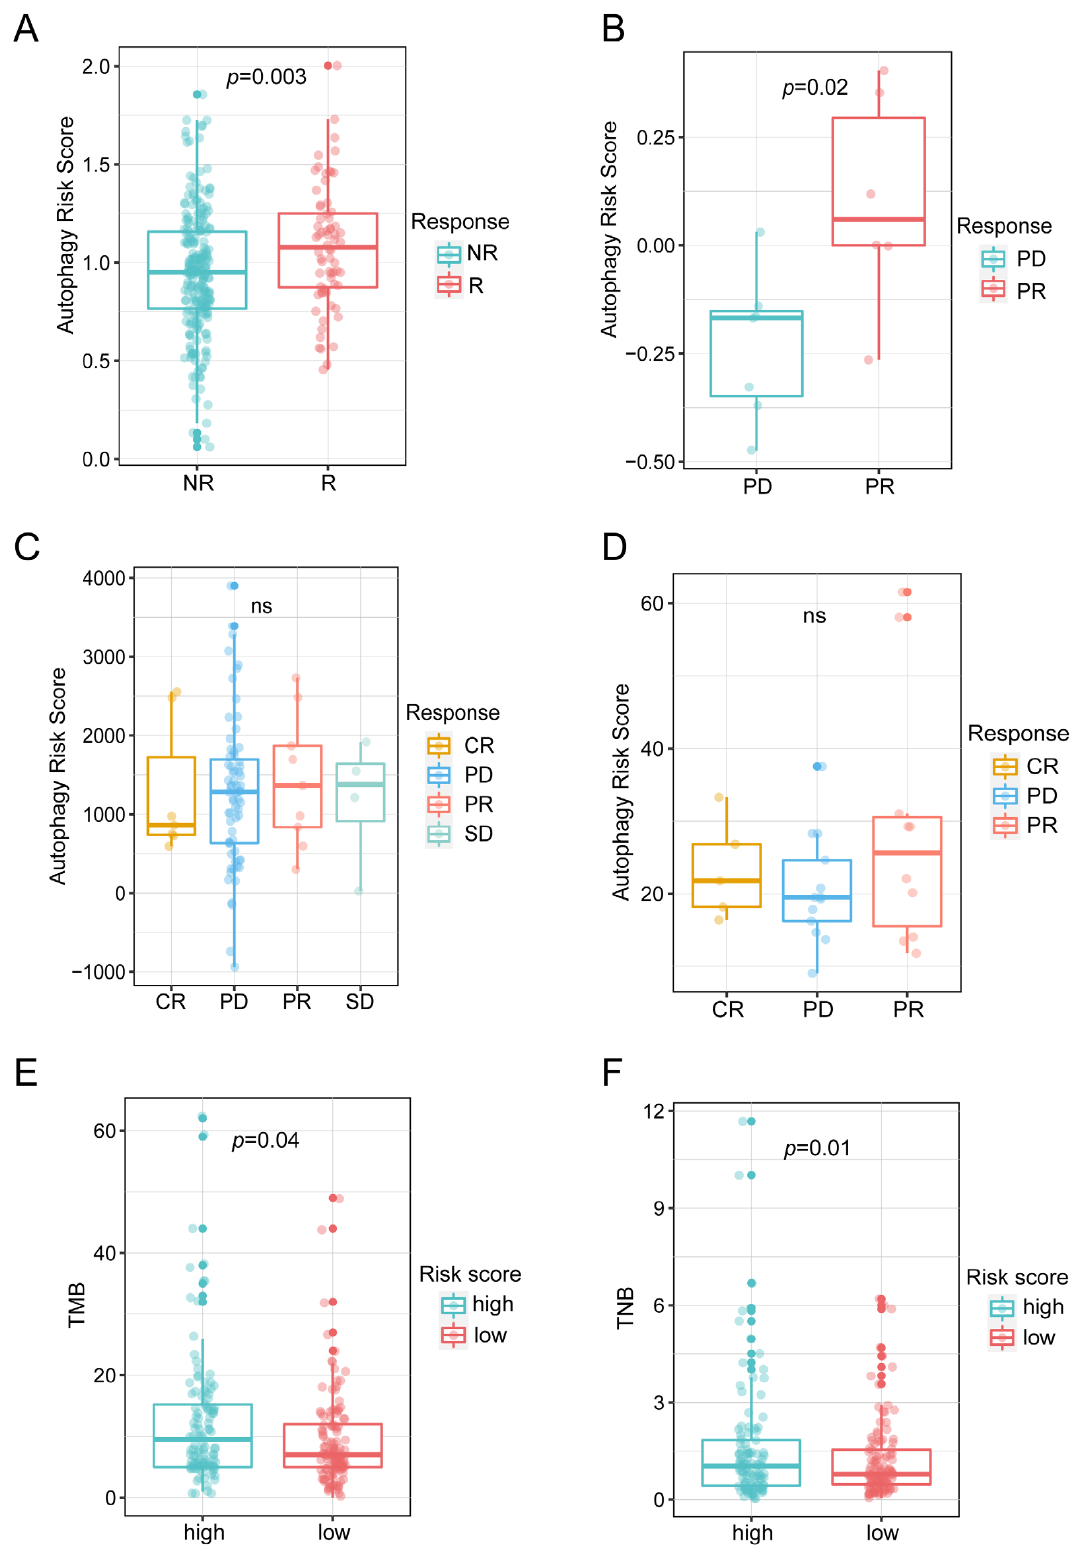
Figure 7. Evaluation of the ICIs therapy efficiency based on autophagy-related signature: Autophagy risk score in the patients with different responses to immunotherapy in the IMvigor210 cohort ( A ), an institutional cohort ( B ), GSE176307 ( C ) and GSE78220 cohort ( D ). TMB ( E ) and TNB ( F ) values (IMvigor210) of the patients with autophagy high/low risk score (ns, no statistical difference).